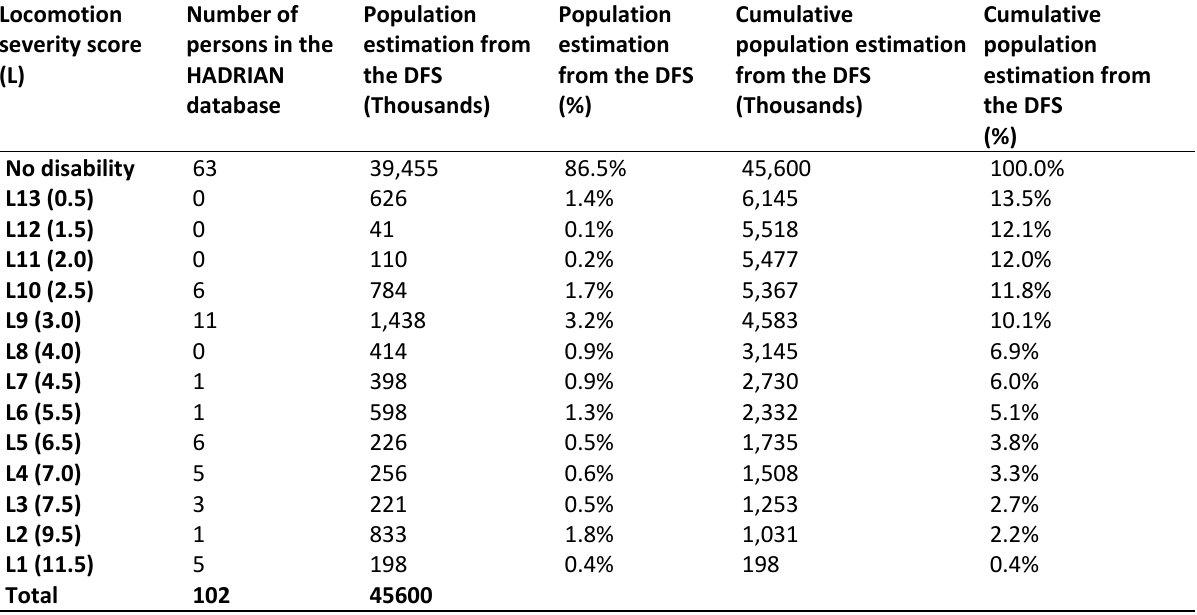
Table 6. HADRIAN severity scores and DFS-based population estimation for locomotion. Locomotion